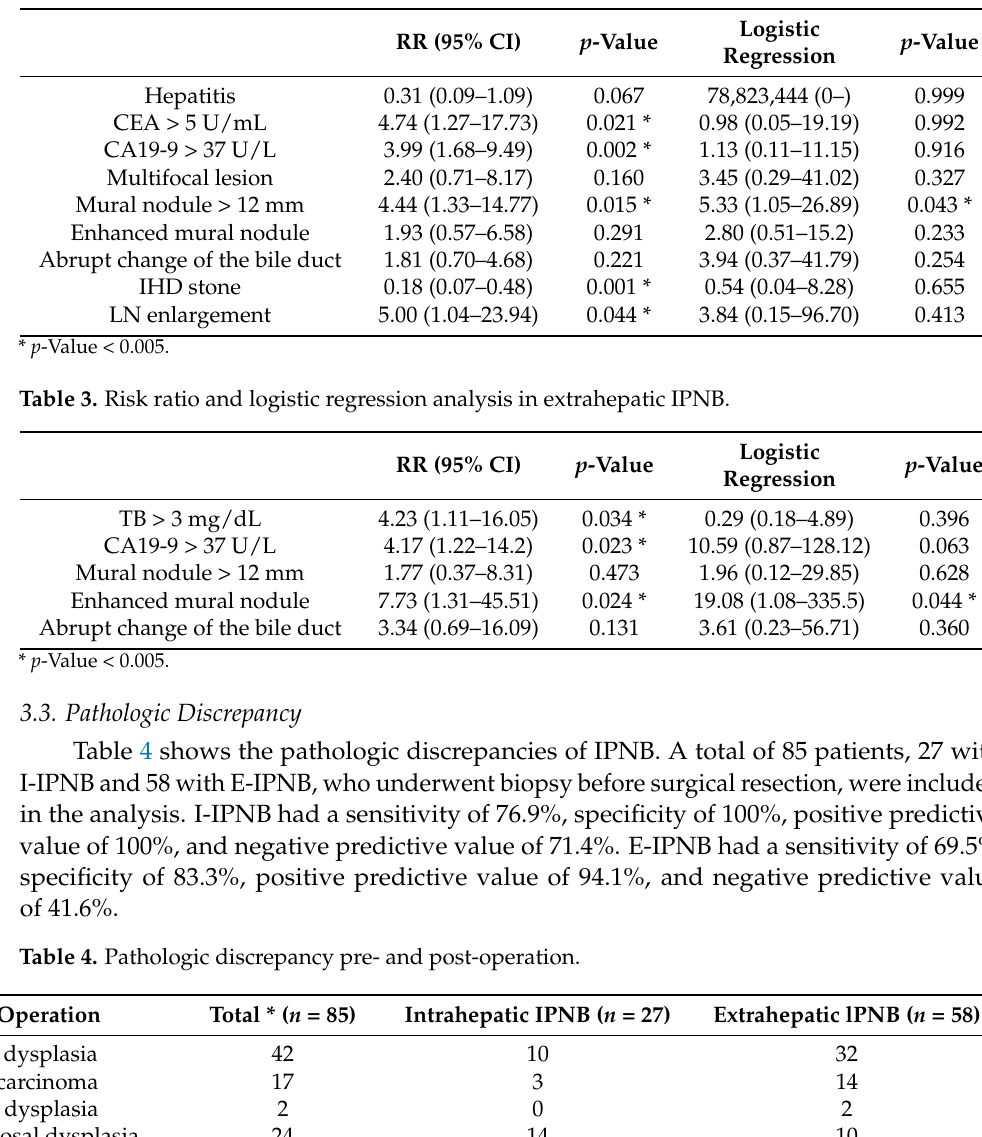
Table 2. Risk ratio and logistic regression analysis in intrahepatic IPNB.